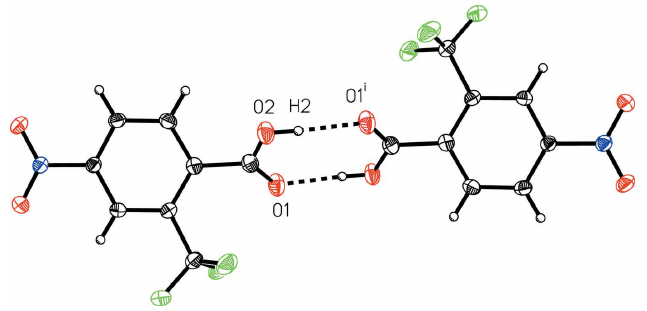
Figure 4 A view of the intermolecular hydrogen bonding in 4-nitro-2-(trifluoro- methyl)benzoic acid (I). [Symmetry code: (i) (cid:5) x + 1, (cid:5) y + 1, (cid:5) z